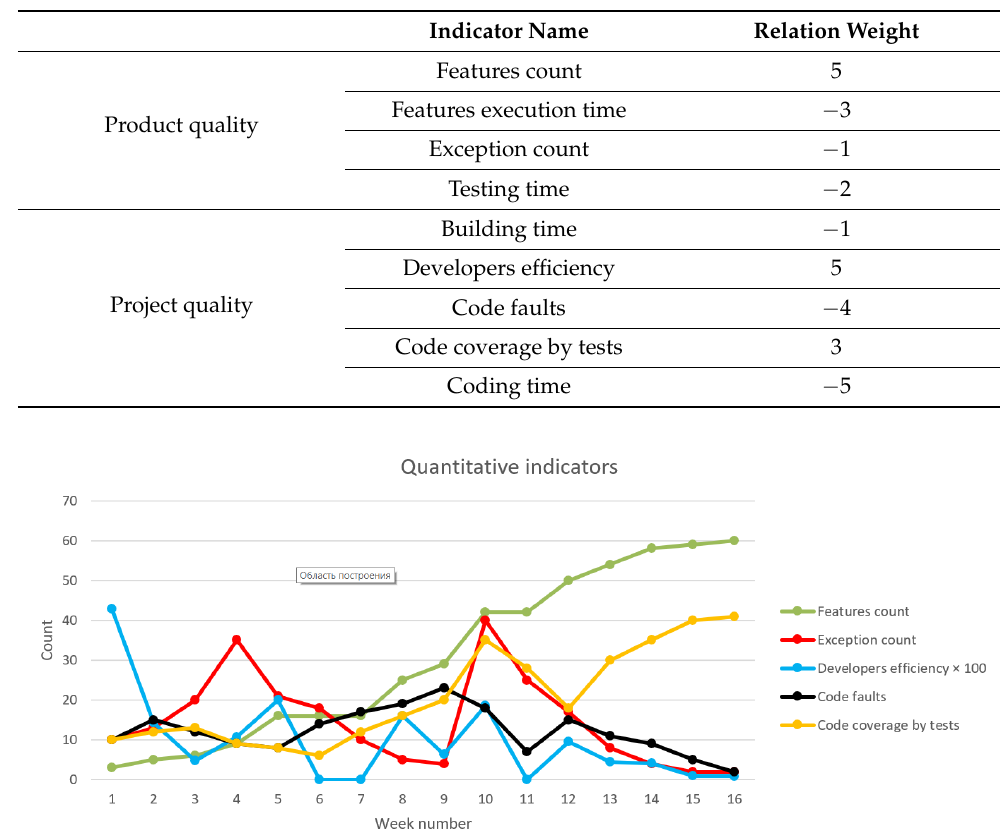
Table 2. Indicators of development and theirs impact on quality models.